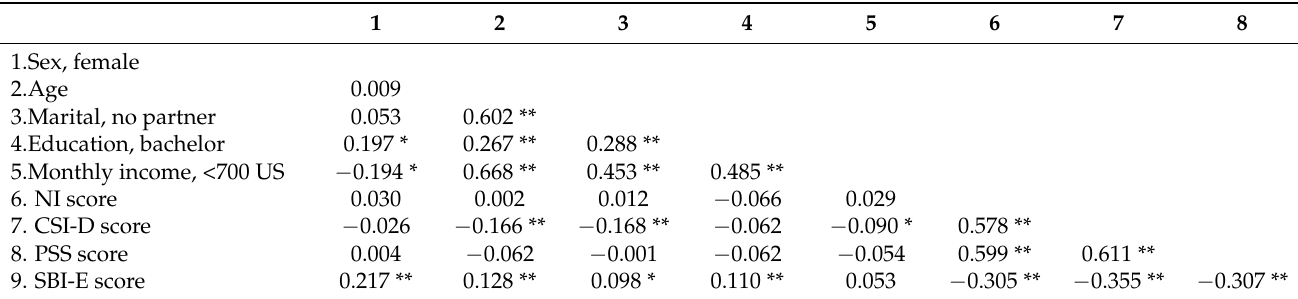
Table 2. Correlation matrix between